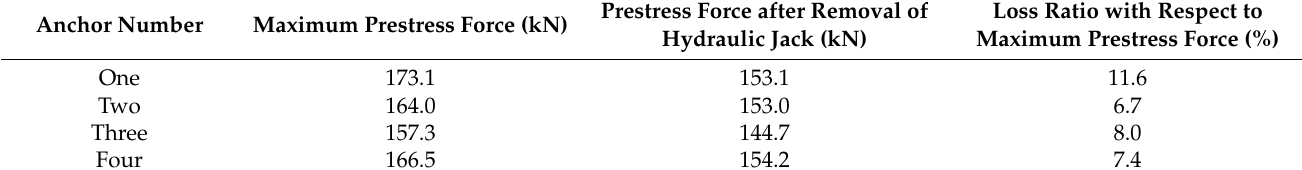
Table 3. Immediate loss of prestress force per anchor.